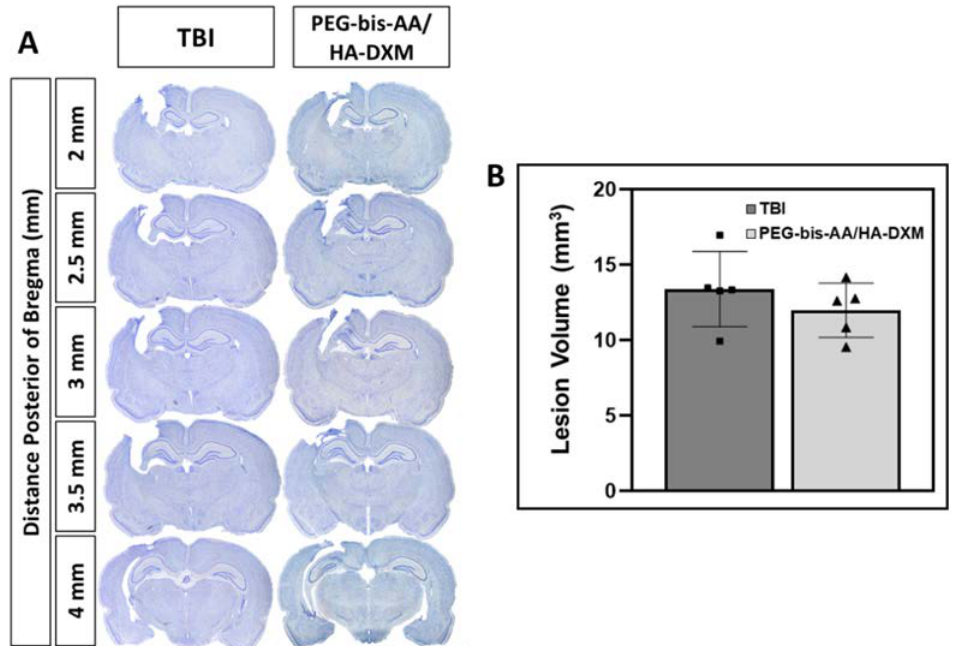
Figure 3. The effect of PEG-bis-AA/HA-DXM hydrogel treatment on average lesion volume at 14 DPI by Nissl staining. ( A ) Representative images of Nissl-stained sections are shown for 2 mm, 2.5 mm, 3 mm, 3.5 mm, and 4 mm posterior of the bregma. Scale bar = 2 mm. ( B ) Average lesion volume calculated by Cavalieri approximation. A total of 10 evenly spaced sections per animal (0.25 µm spacing, 2 mm to 4.25 mm posterior of the bregma). ( n = 5 rats/group; data presented mean ± SD, ONE - WAY ANOVA, post hoc: Tukey HSD).